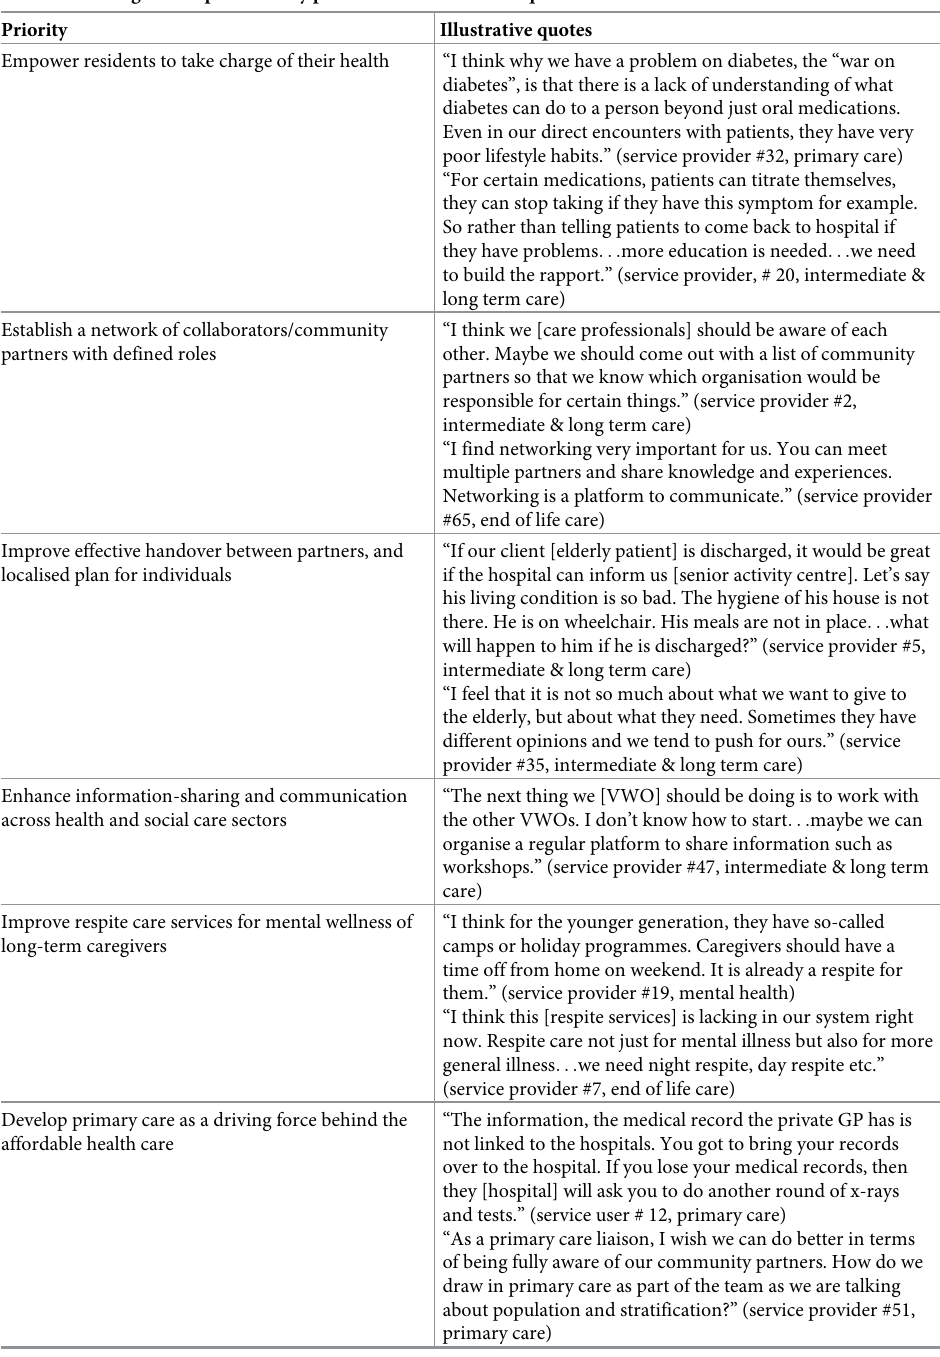
Table 4. Findings of the phase 3 –key priorities and illustrative